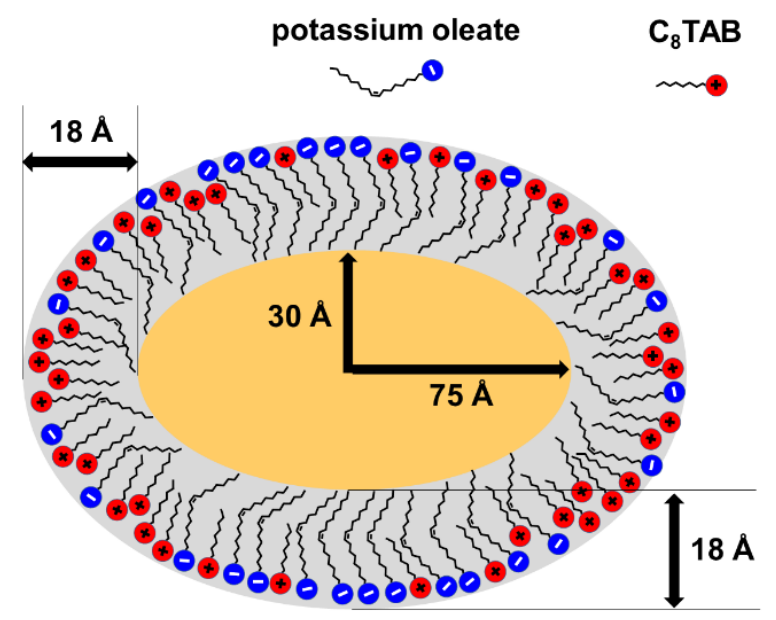
Figure 6. Schematic representation of an elliptical microemulsion droplet formed in aqueous solutions containing 117 mM C8TAB, 78 mM potassium oleate, and 210 mM n-decane.